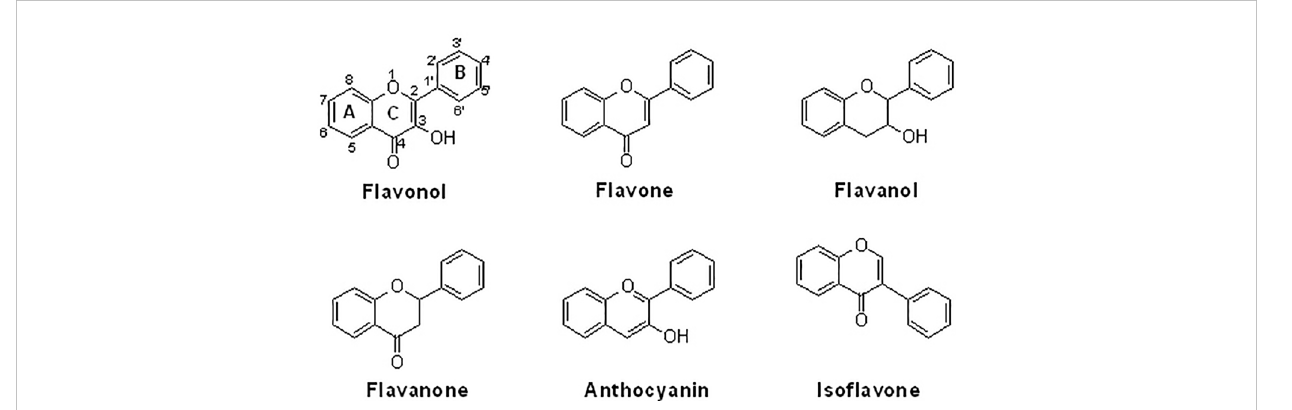
FIGURE 1 The chemical structures of six sub-groups of fl avonoids. Natural fl avonoids can be divided into fl avonol, fl avone, fl avanol, fl avanone, anthocyanin, and iso fl